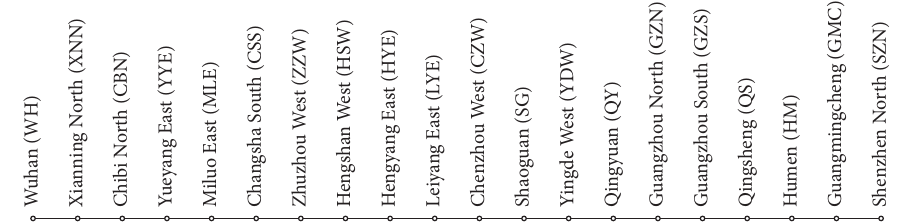
Figure 2: The line map of the downward direction of WH to SZN of China WGHSR. Table 3: Train composition table of numerical instance.